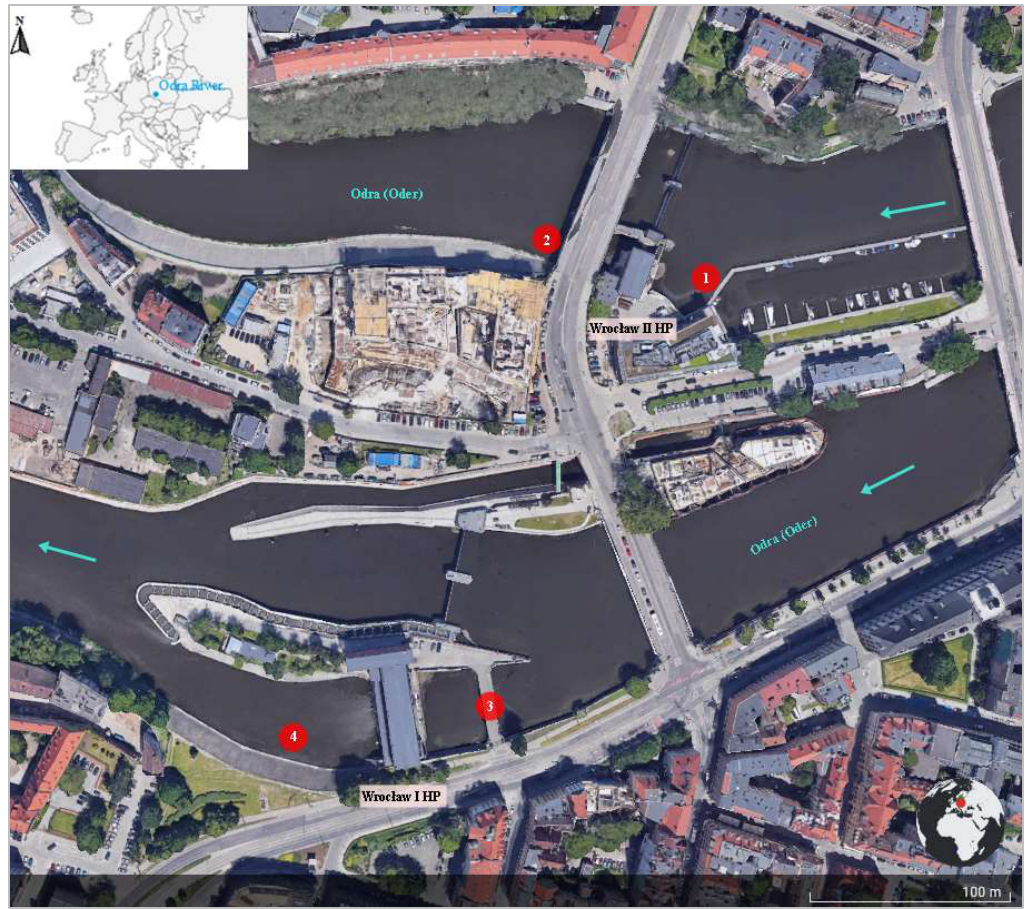
Figure 1. Location of observation points within Wrocław I and Wrocław II hydropower plants (HPs) on the Odra River in Poland (1—point upstream Wrocław II HP, 2—point downstream Wrocław II HP, 3—point upstream Wrocław I HP, 4—point downstream Wrocław I HP).